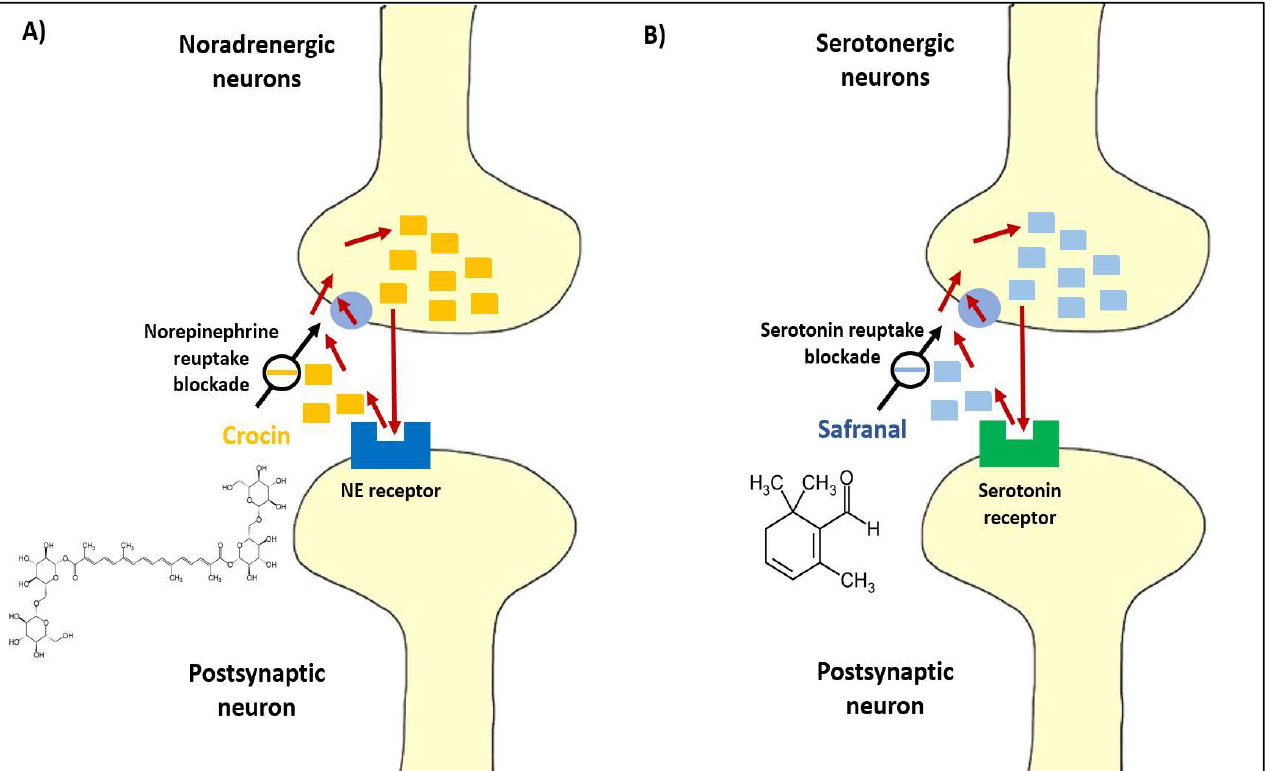
Figure 3 . Illustration of the mechanism of inhibiting of norepinephrine (NE) reuptake and serotonin reuptake by ( A ) crocin and ( B ) safranal, respectively [101].